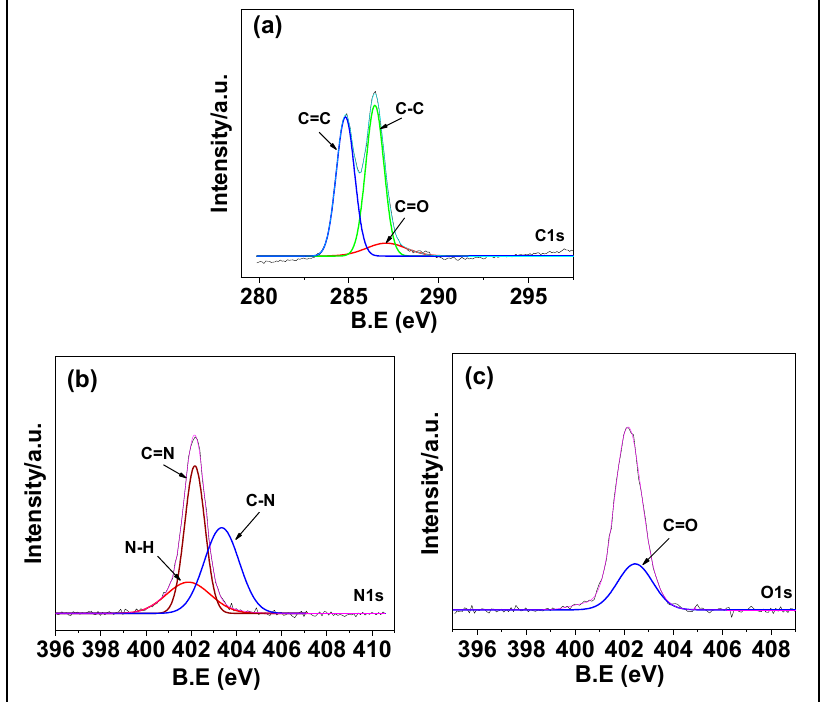
Figure 2. XPS analysis of PNIPAm-co-PAAm-Mela HG. The core level spectra of ( a ) C 1s; ( b ) N 1s; and ( c ) O 1s, respectively.